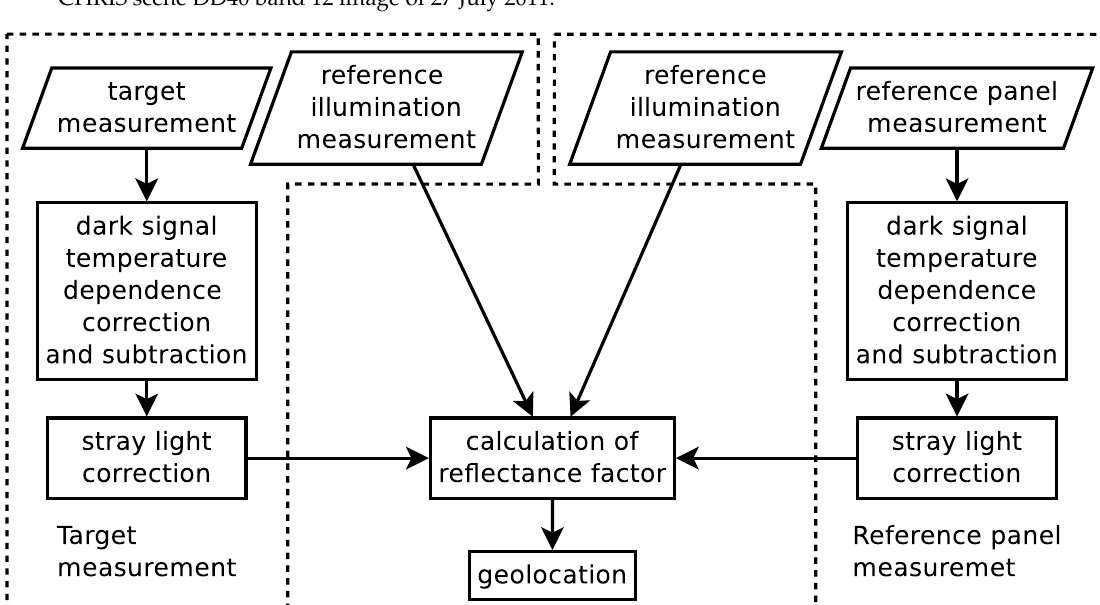
Figure 2. Data processing steps for calculating reflectance factors